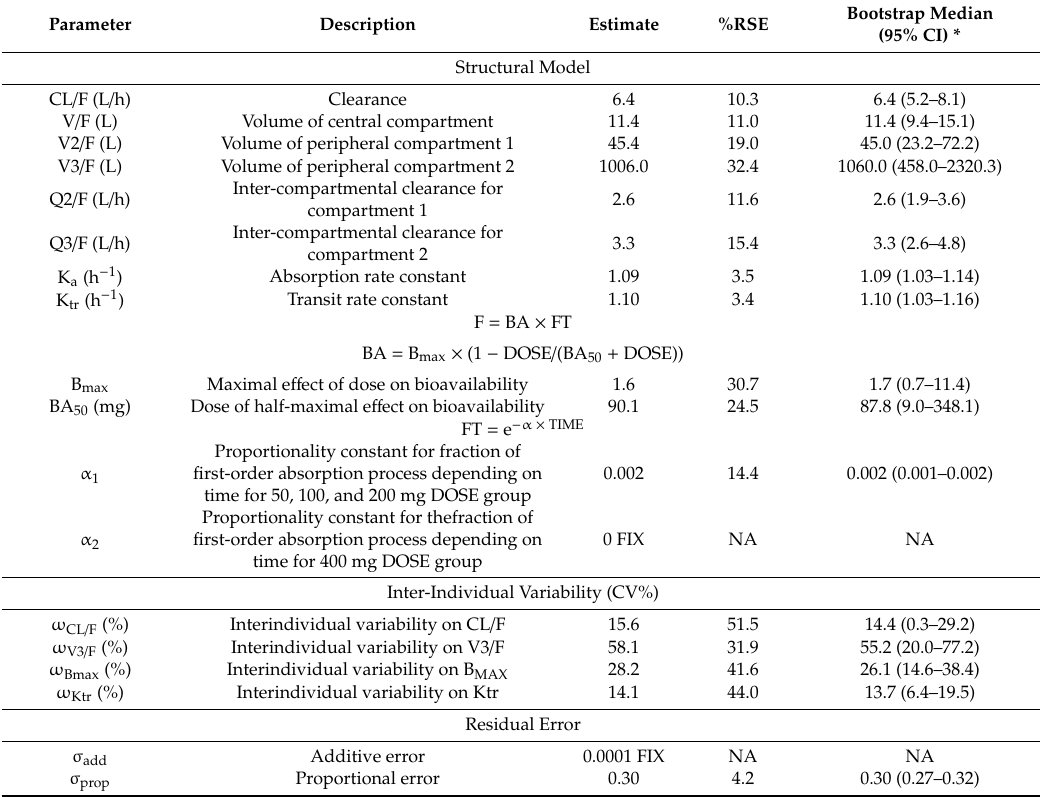
Table 2. Parameter estimates from the final population pharmacokinetic